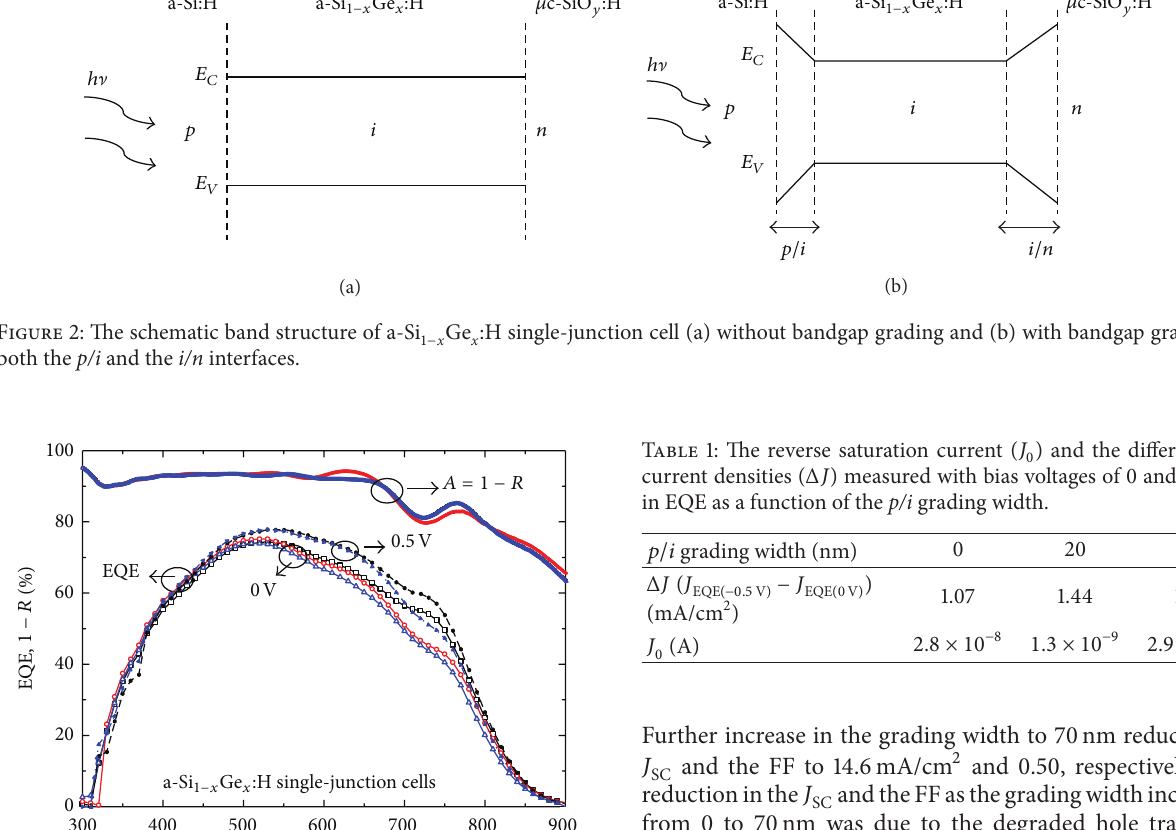
Ge :Hsingle-junction x x